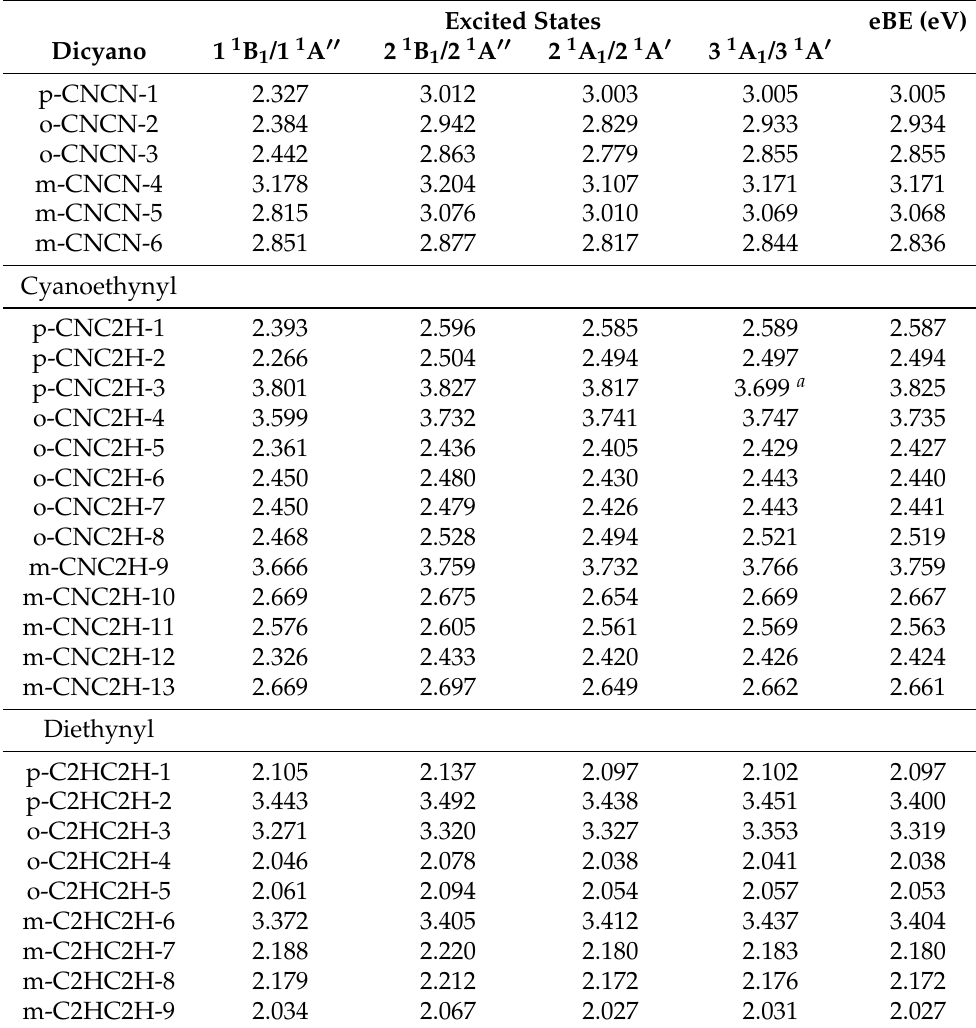
Table 2. EOM-CCSD/aug-cc-pVDZ+6s6p2d electronically excited states and eBEs (all in eV) of the difunctionalized benzene derivative